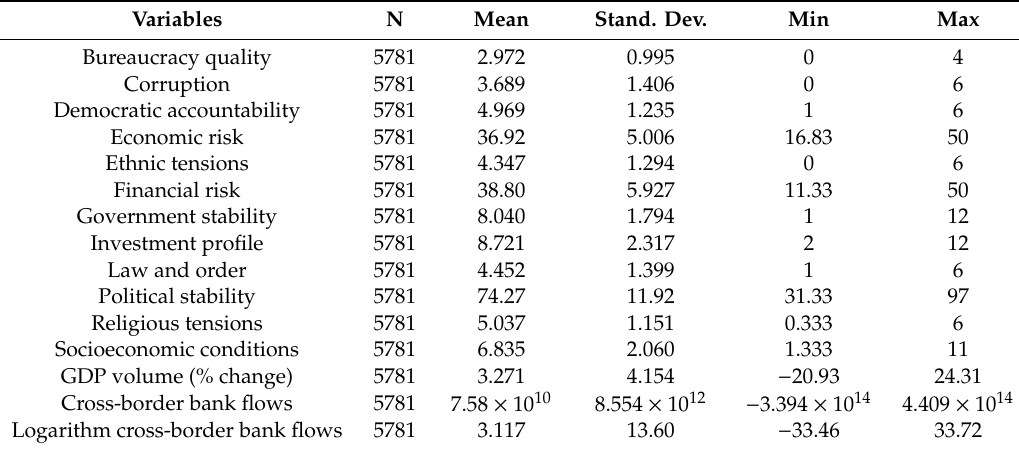
Table A1. Descriptive statistics—all countries.